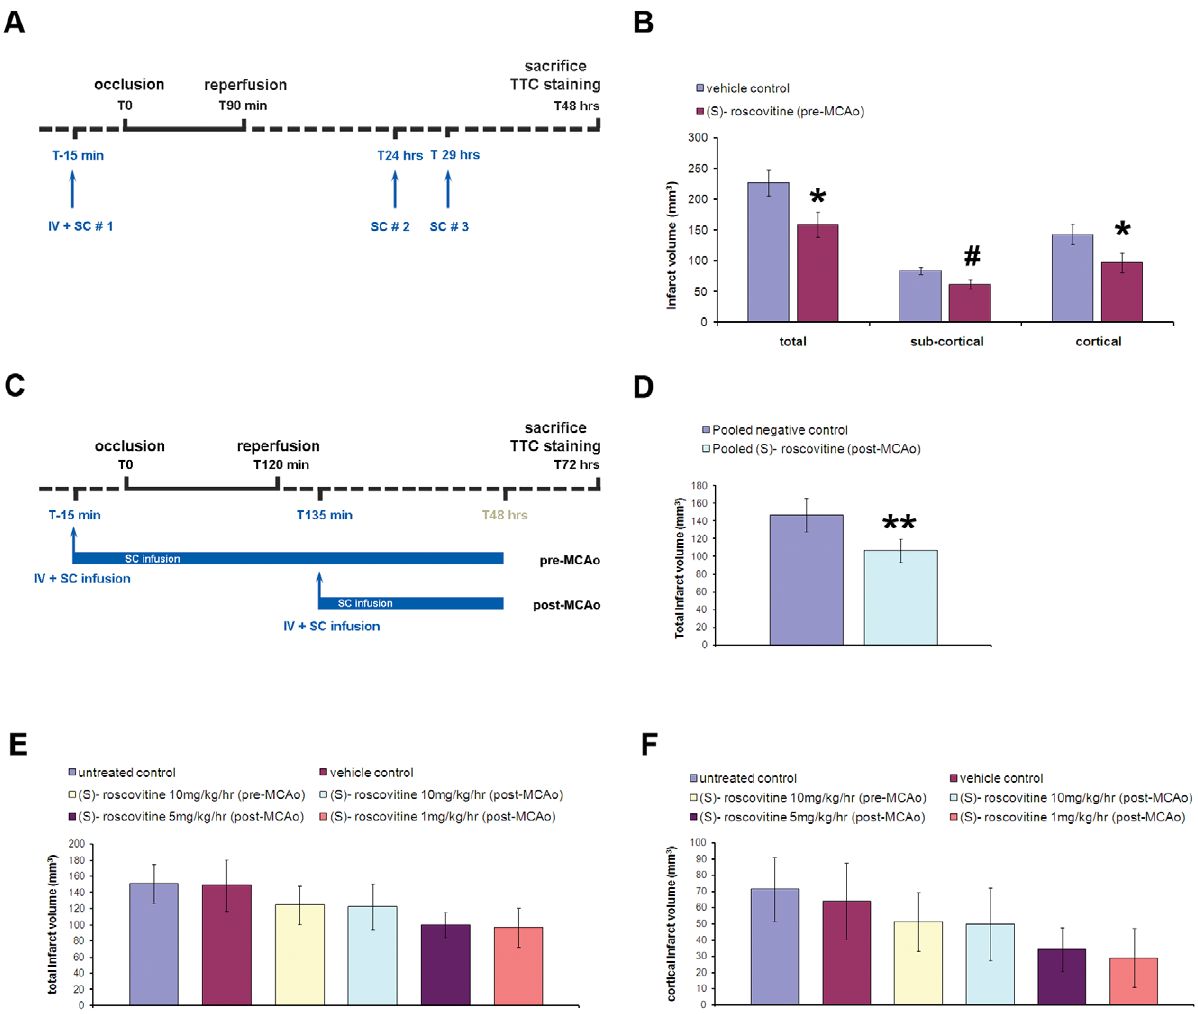
Figure 2. Systemic (S)-roscovitine decreases lesion infarct size after transient focal ischemia in rat when administered prior or 2h15 after the ischemia onset. Two independent blinded studies were performed at Neurokin ( A, B ) and by MDS Pharma Services ( C–F ). ( A ) Scheme of the experimental protocol performed at Neurokin. Transient focal ischemia was induced in adult rats for 90 min. (S)-roscovitine (n=16 rats) or its vehicle control (n=18 rats) was administered 15 min prior the occlusion by a IV bolus at one dose (25 mg/kg) and 3 successive SC injections at one dose (54 mg/kg) performed 15 min prior, 24 and 29 hrs after the occlusion. Rats were analyzed by TTC staining at 48 hrs post-occlusion. ( B ) Evaluation of the corrected infarct volumes in this experiment revealed a significant reduction by 30%, 33% and 26% respectively of the total, sub- cortical, and cortical areas of the brain lesion in presence of (S)-roscovitine administered 15 min prior the ischemia onset. ( C ) Scheme of the experimental protocol performed at MDS PS. tMCAo was induced for 120 min. (S)-roscovitine (3 doses tested, n=12 rats per dose) or its vehicle control (n=13 rats) was administered to tMCAo rats either prior (pre-MCAo) or 135 min after (post-MCAo) the ischemia onset. (S)-roscovitine or vehicle administration was done by an IV bolus at one dose (25 mg/kg) followed by SC infusion at 3 decreasing doses for 48 hrs (10, 5, and 1 mg/kg). In addition, untreated control tMCAo animals (n=11 rats) were also prepared. Animals were sacrificed at 72 hrs after the occlusion and their brains were analyzed by TTC staining. ( D ) Analysis of the corrected infarct volumes at 72 hrs after a 120 min tMCAo showed no significant difference in total infarct volume between the vehicle control group and the untreated control group, indicating the absence of effect of the vehicle used in our study. Therefore, both untreated and vehicle treated groups were pooled in one negative control group. Similarly, (S)-roscovitine- treated groups were pooled in one group containing the three post-MCAo treated groups only (post- MCAo). A significant decrease of the corrected total infarct volumes was observed when the pooled negative control was compared to the pooled (S)-roscovitine post-MCAo treated groups. ( E ) In contrast, no significant difference was observed between the control groups and each (S)-roscovitine treated group independently of the dose or the administration time. ( F ) Although not statistically significant, a dose-dependent beneficial effect of (S)-roscovitine on the lesion volume was observed mostly on the cortical region of the brain lesion by reducing the volume by 30%, 52% and 58% respectively at 10, 5 and 1 mg/kg/hr, *p , 0.01, ** p , 0.05, t -test # p , 0.01, Mann Whitney